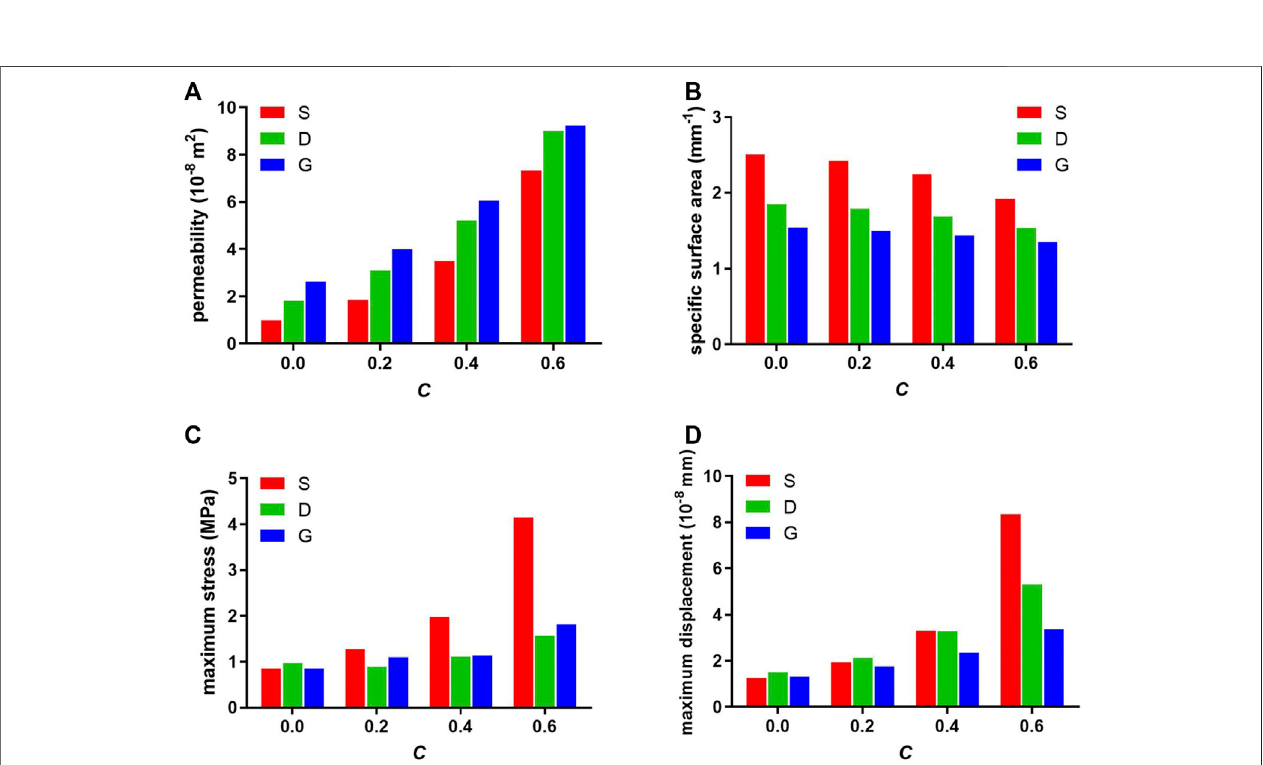
FIGURE5| Designed (A) permeability, (B) speci fi csurfacearea,and fi niteelement analyzed (C) maximum stress, (D) maximumdisplacementofporousscaffolds.